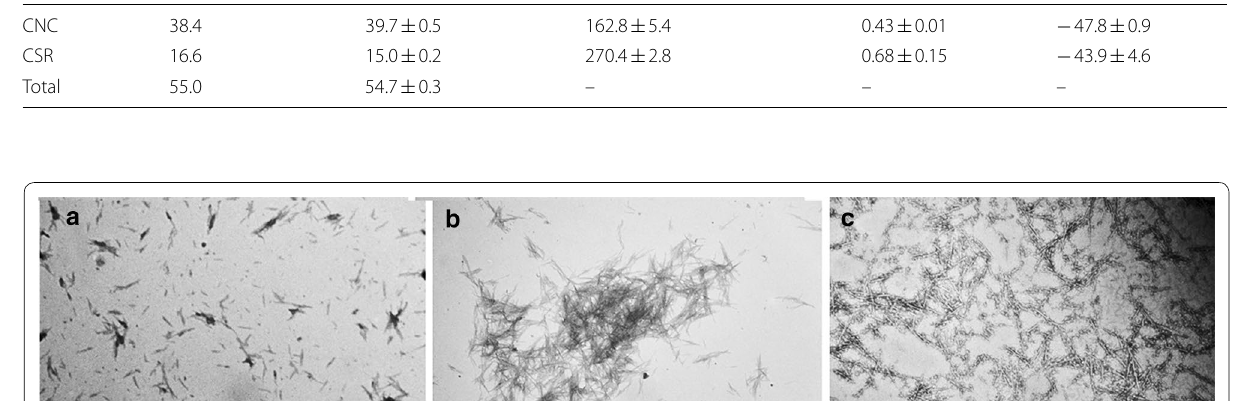
Table 5 Evaluation of yields and properties of CNCs and CSR at optimum conditions Predicted yield (%)